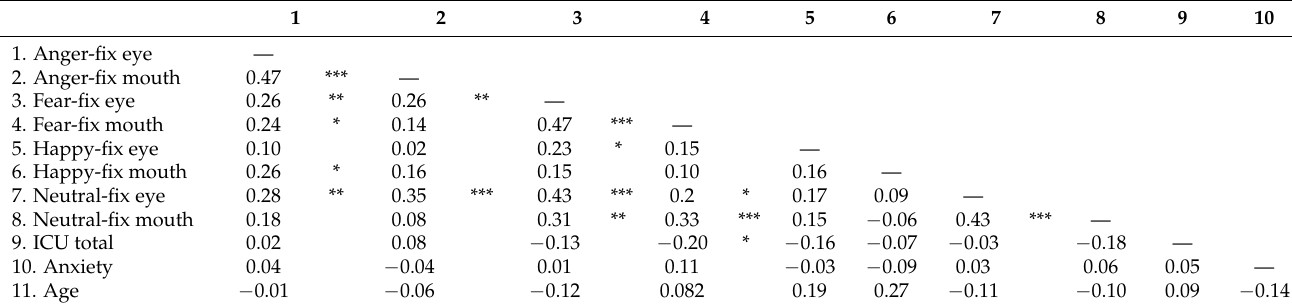
Table 2. Correlations ( Kendall’s tau ) among CU traits, anxiety, and age and emotion recognition when eyes were fixated and when the mouth was